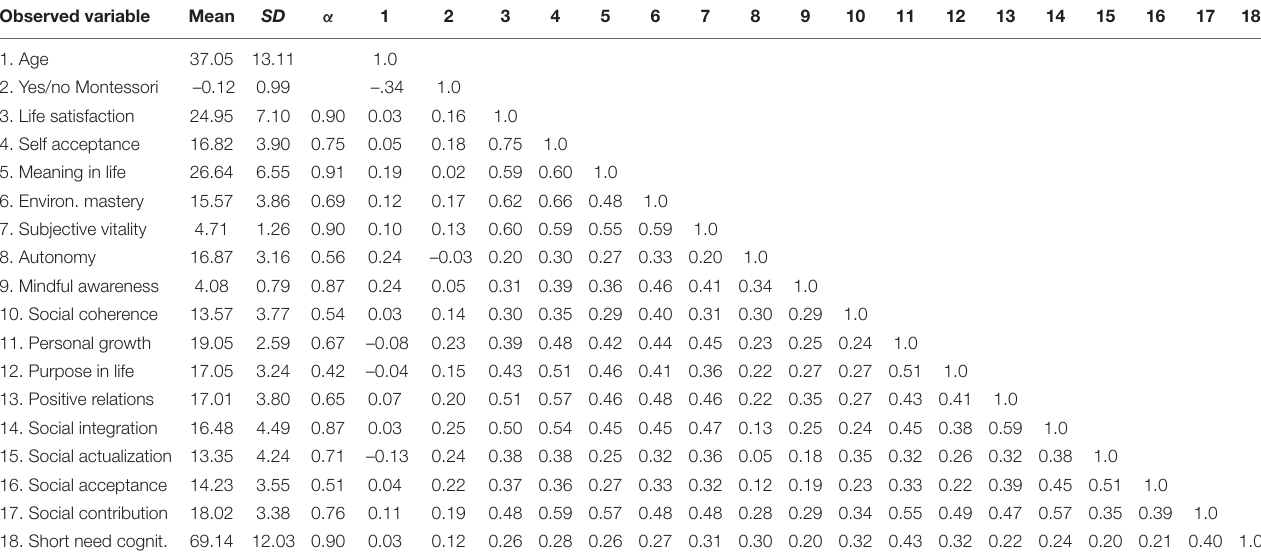
TABLE 1A | Means, SDs, and correlation matrix for observed continuous variables: entire sample. Observed variable